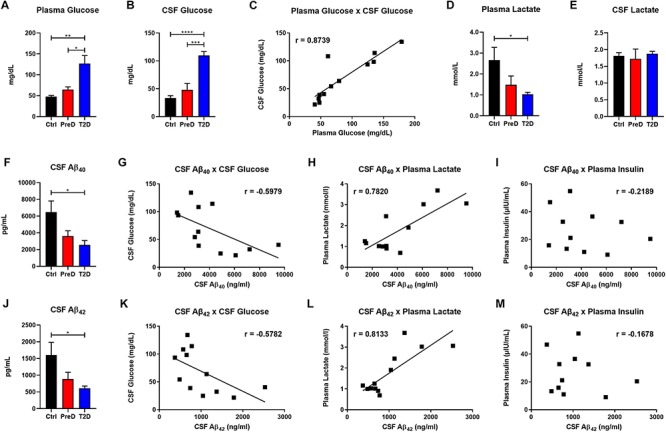
Type 2 diabetes (T2D) monkeys have significantly decreased cerebrospinal fluid (CSF) Aβ40 and CSF Aβ42 concentrations, which is correlated with CSF glucose and plasma lactate concentrations. (A) plasma glucose and (B) CSF glucose concentrations were significantly elevated in T2D monkeys. (C) Plasma and CSF glucose concentrations were significantly correlated. (D) T2D monkeys had significantly decreased plasma lactate, but not (E) CSF lactate. (F) T2D monkeys had significantly decreased Aβ40, which was correlated with (G) CSF glucose and (H) plasma lactate, but not (I) plasma insulin concentrations. (J) Similarly, T2D monkeys had significantly decreased Aβ42 concentrations, which was correlated with (K) CSF glucose and (L) plasma lactate, but not (M) plasma insulin concentrations.∗p < 0.05; ∗∗p < 0.01; ∗∗∗p < 0.001; and ∗∗∗∗p < 0.0001; one-way ANOVA with Tukey’s post hoc test. Values represent mean ± SEM; solid lines represent statistically significant correlations (p < 0.05).